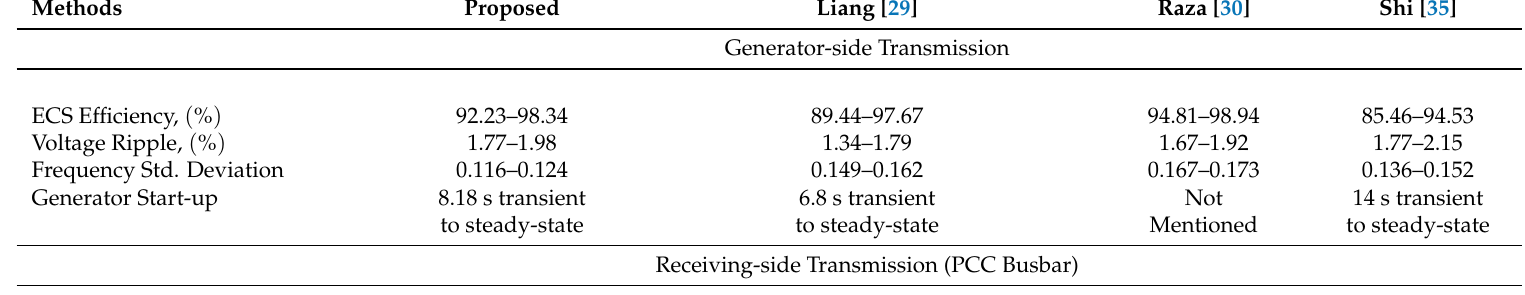
Table 7. Performance comparisons against other control schemes and collection system design for large-scale deployment—ECS: Energy Conversion